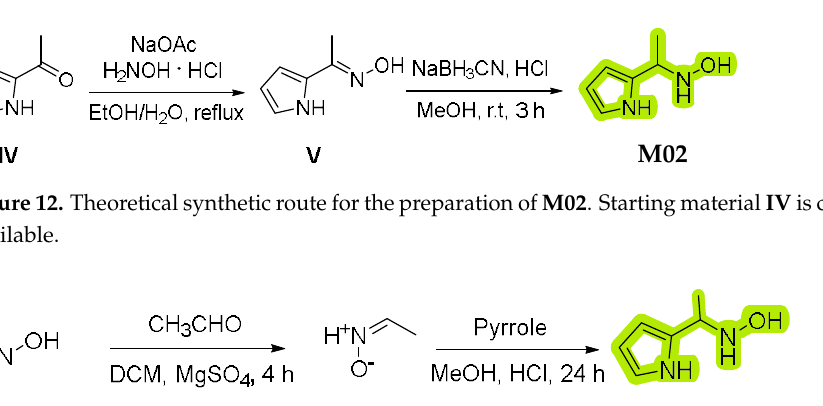
Figure 12. Theoretical synthetic route for the preparation of M02 . Starting material IV is commer- Figure 13. Alternative synthetic route for the preparation of M02 . Starting material VI is commer- cially available. cially available.